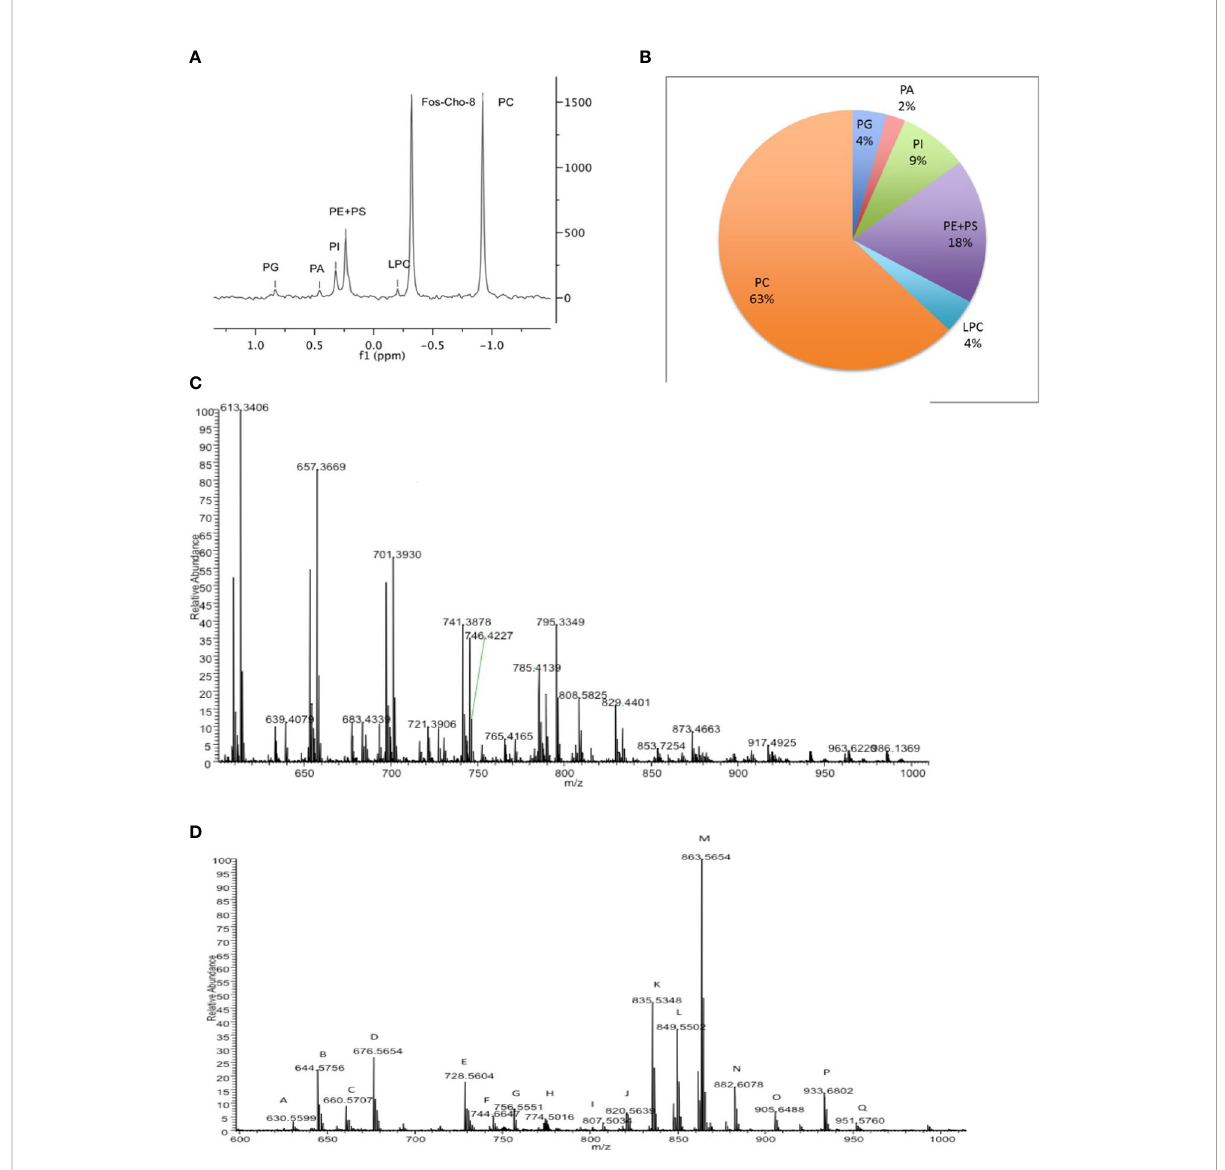
FIGURE 1 Crithidia fasiculata Phospholipid Composition (A) (Mwenechanya et al., 2017)P-NMR analysis of cellular lipid extract. (B) Quantitation of phospholipid content by head-group (Mwenechanya et al., 2017)P NMR. High resolution mass spectrometry survey scan of lipid extract in (C) positive mode and (D) negative